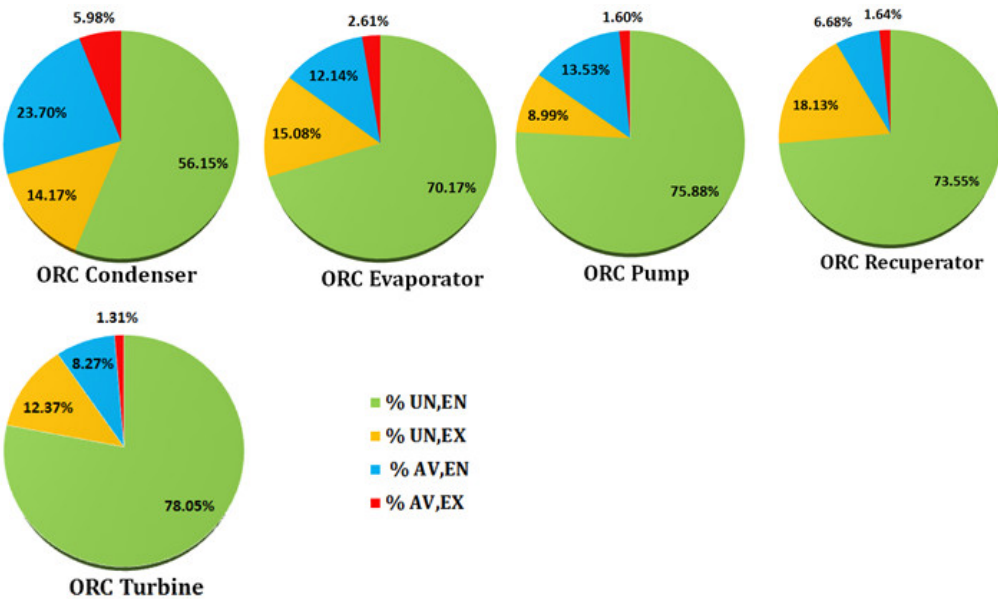
Figure3. Figure 3. Advanced exergy destruction rate of each component in the standalone geothermal cycle (GPP).